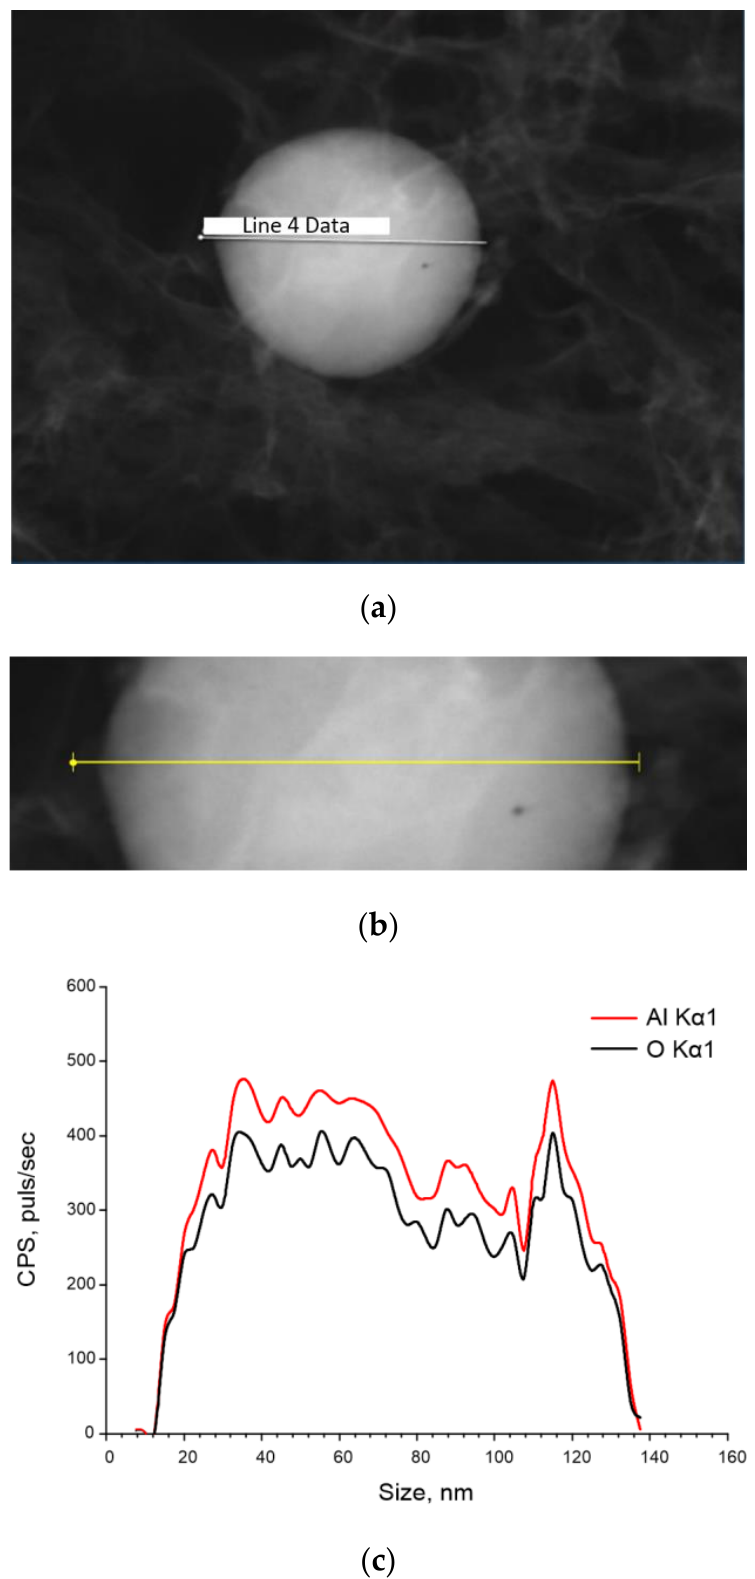
Figure 3. Elemental analysis of Al 2 O 3 NPs: ( a ) TEM image of Al 2 O 3 NP, analysis section is indicated with line 1; ( b ) Enlarged measurement site; ( c ) Nanoparticle profile by Al K α 1 and O K α 1.